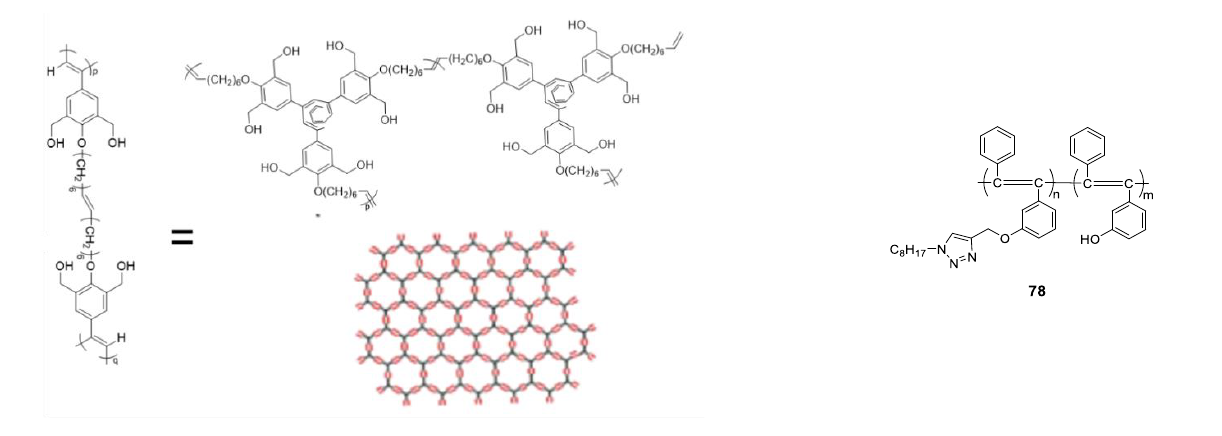
Table 5. Categorization and detailed data for the membrane polymers in Figure 7 (PAs in 2020). Code